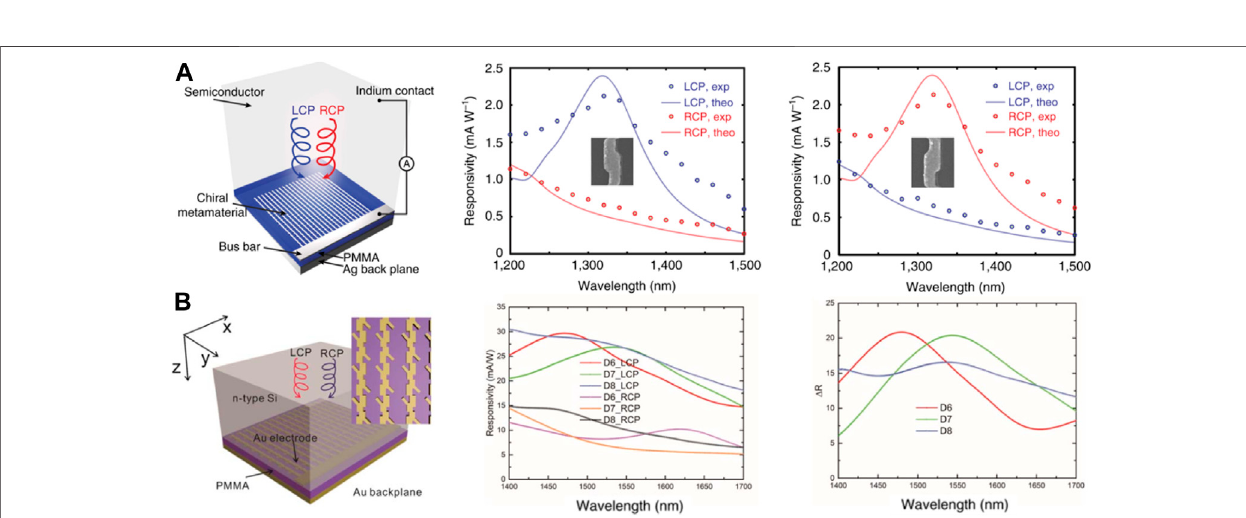
FIGURE 6 | (A) Shematic of a CPL detector consisting of a chiral metamaterial integrated with a semiconductor that serves as a hot electron acceptor and experimentally measured optical absorption spectra under LCP and RCP illumination for LH and RH metamaterials (Li et al., 2015). Reproduced with permission. Copyright 2015, Nature Publishing Group. (B) Schematic of a 2D CPL photodetector integrated on n-type silicon, responsivity of the CPL photodetector based on 2D chiral metamaterials, and different optical responses of the three devices (Xiao et al., 2019). Reproduced with permission. Copyright 2019, IOP Publishing Ltd.